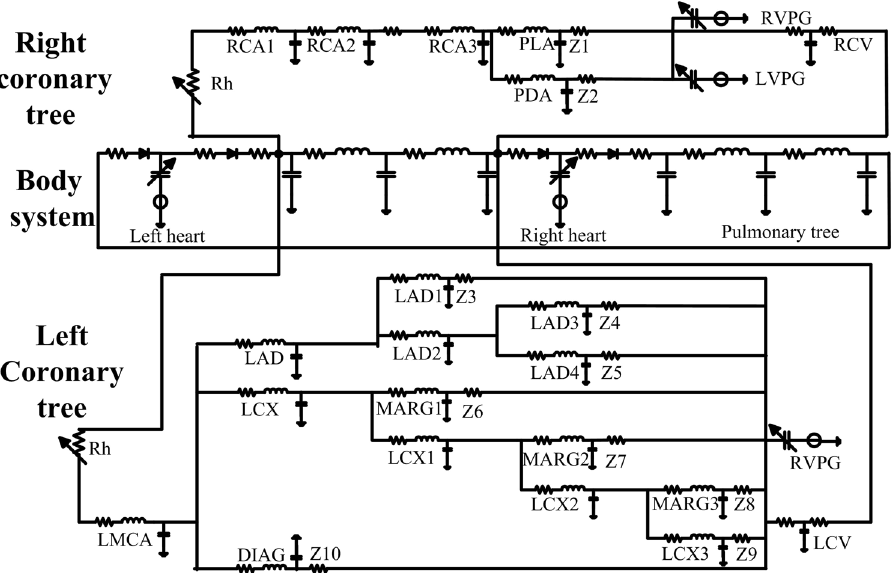
Figure 7. The coronary tree is represented by a closed loop cardiovascular system, where R h is the variable resistance due to head loss, and Z1 to Z10 are the root impedances for the structured tree models attached at the end of the coronary